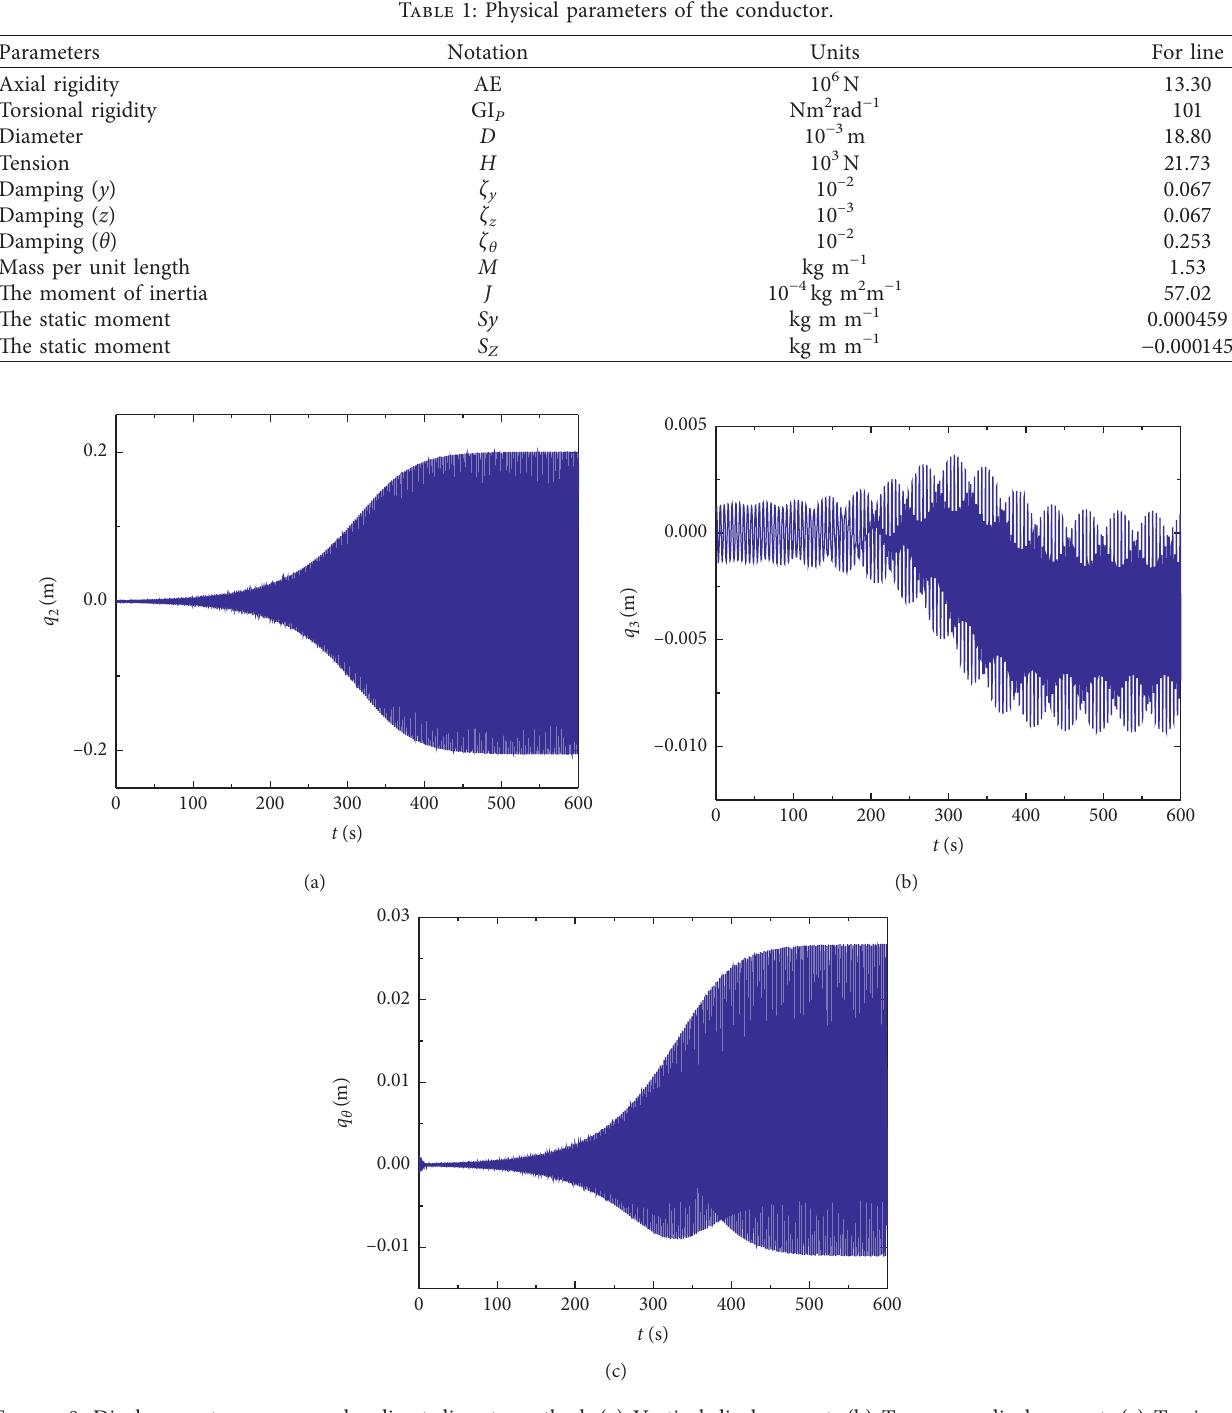
Figure 8: Displacement response under direct discrete method. (a) Vertical displacement. (b) Transverse displacement. (c) Torsional